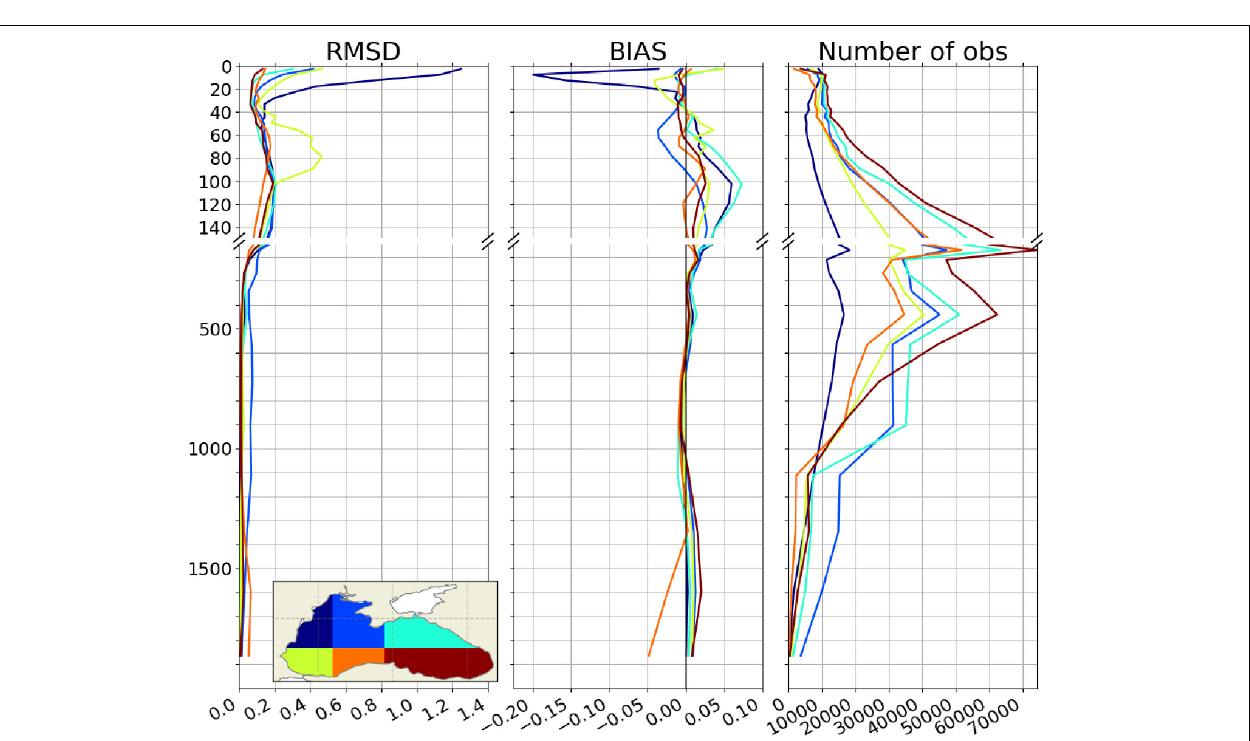
FIGURE 5 | Vertical profiles of the root mean square deviation (left panel), bias (middle panel) and number of observations (right panel) for salinity (PSU) for different sub-domains in the Black Sea, by comparing the BS-REA results against in situ profilers in the Black Sea domain from 1 January 1993 to 31 December 2018.